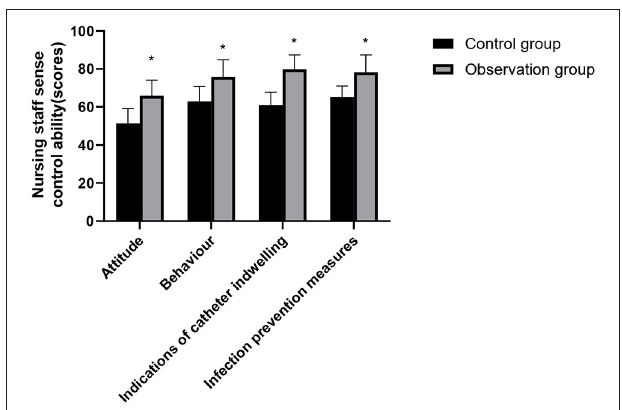
FIGURE 4 | Nursing staff sense control ability comparison between the two groups. Compared with the control group, * p < 0.05.